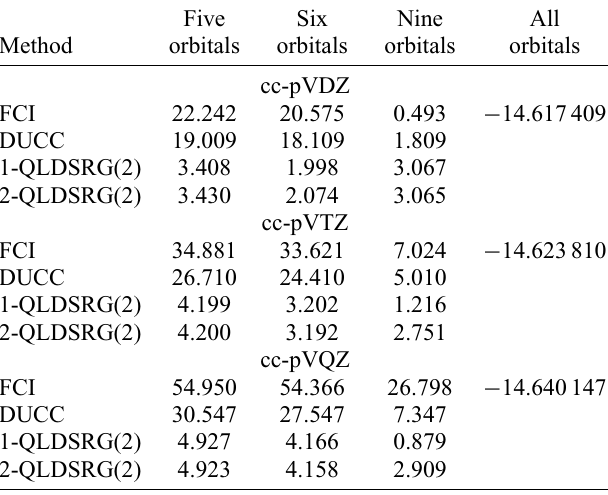
TABLE VIII. A comparison of the energy errors (in m E h ) of the QDSRG and the DUCC for the Be atom with different basis sets and active spaces. The DSRG flow parameter s = 2.0 E − 2 All computations use RHF orbitals. The energy errors are with respect to the full-space FCI computations [absolute energies (in E h ) are shown in the last column], which use 14, 30, and 55 orbitals for the cc-pVDZ, cc-pVTZ, and cc-pVQZ basis sets, respectively. The DUCC data are taken from Ref.